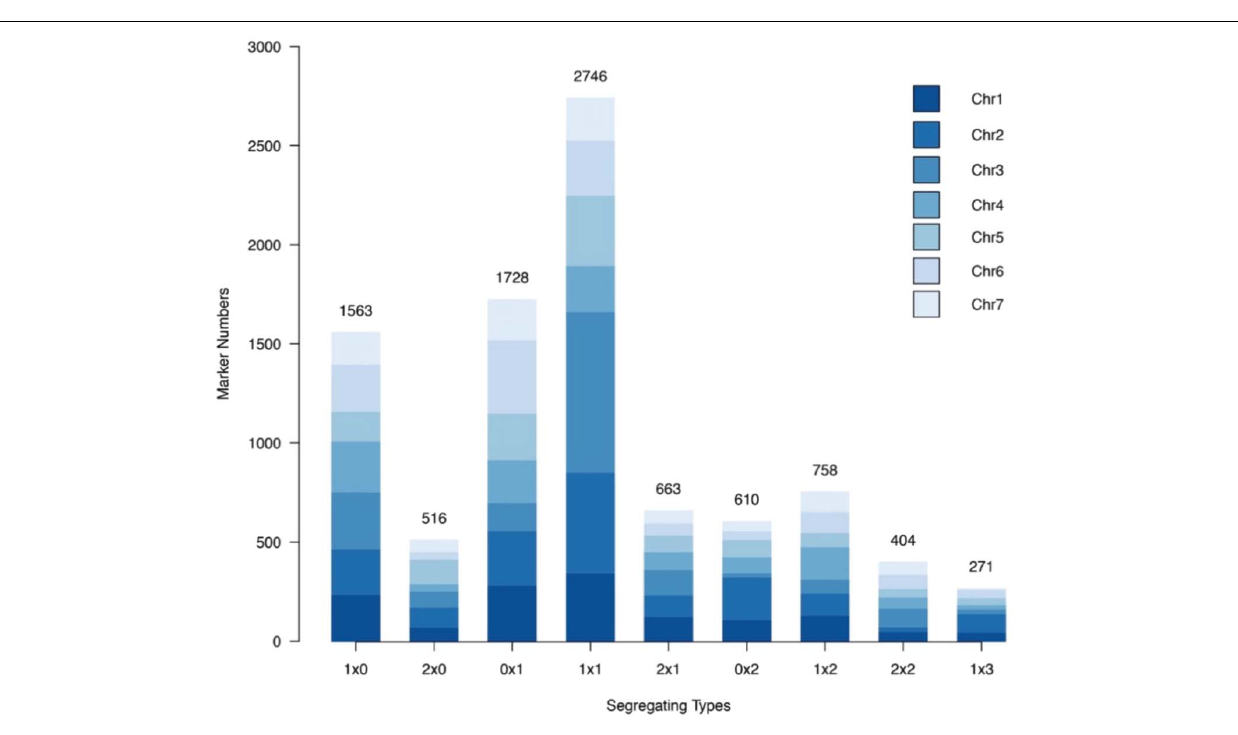
FIGURE 4 | Number of each marker segregation type in the rose YS population among different